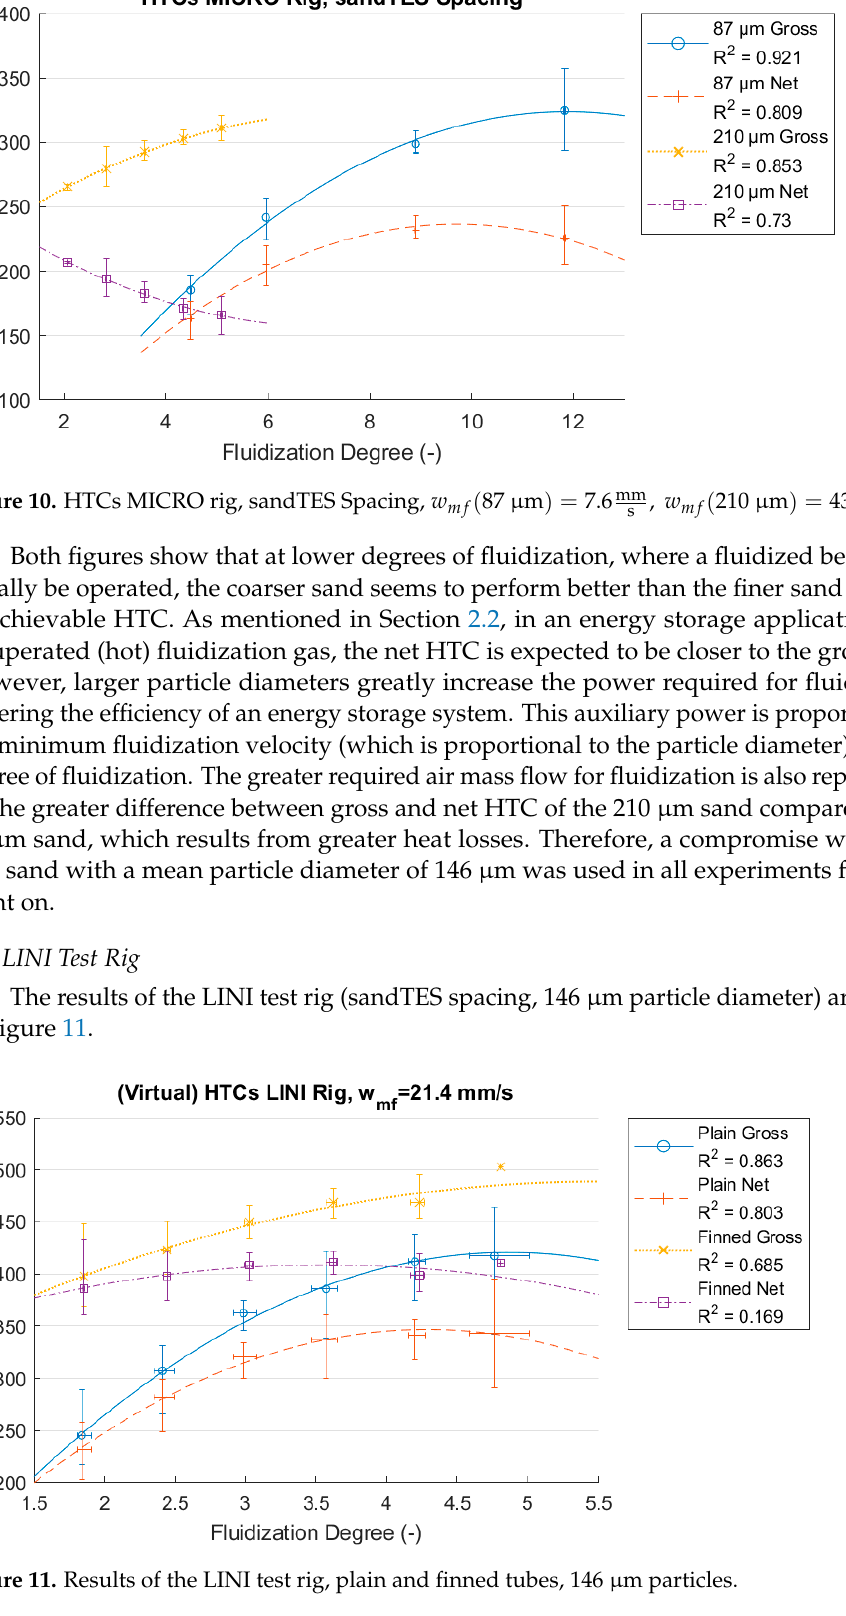
Figure 10. HTCs MICRO rig, sandTES Spacing, 𝑤 (cid:3040)(cid:3033) (87 µ𝑚) = 7.6 (cid:3040)(cid:3040)